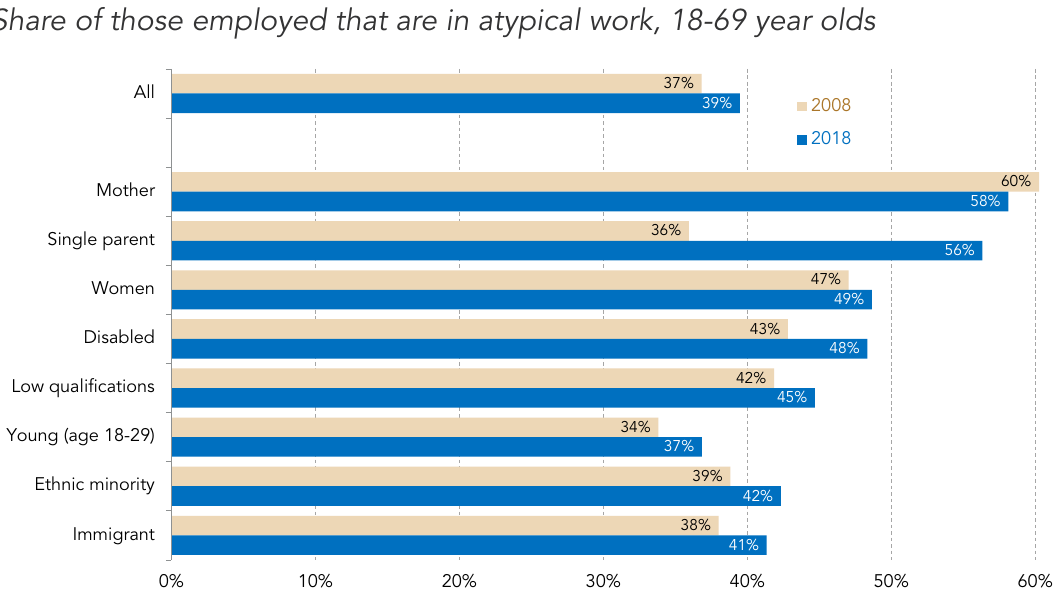
Figure 33: Many groups have experienced an increase in atypical work over the past